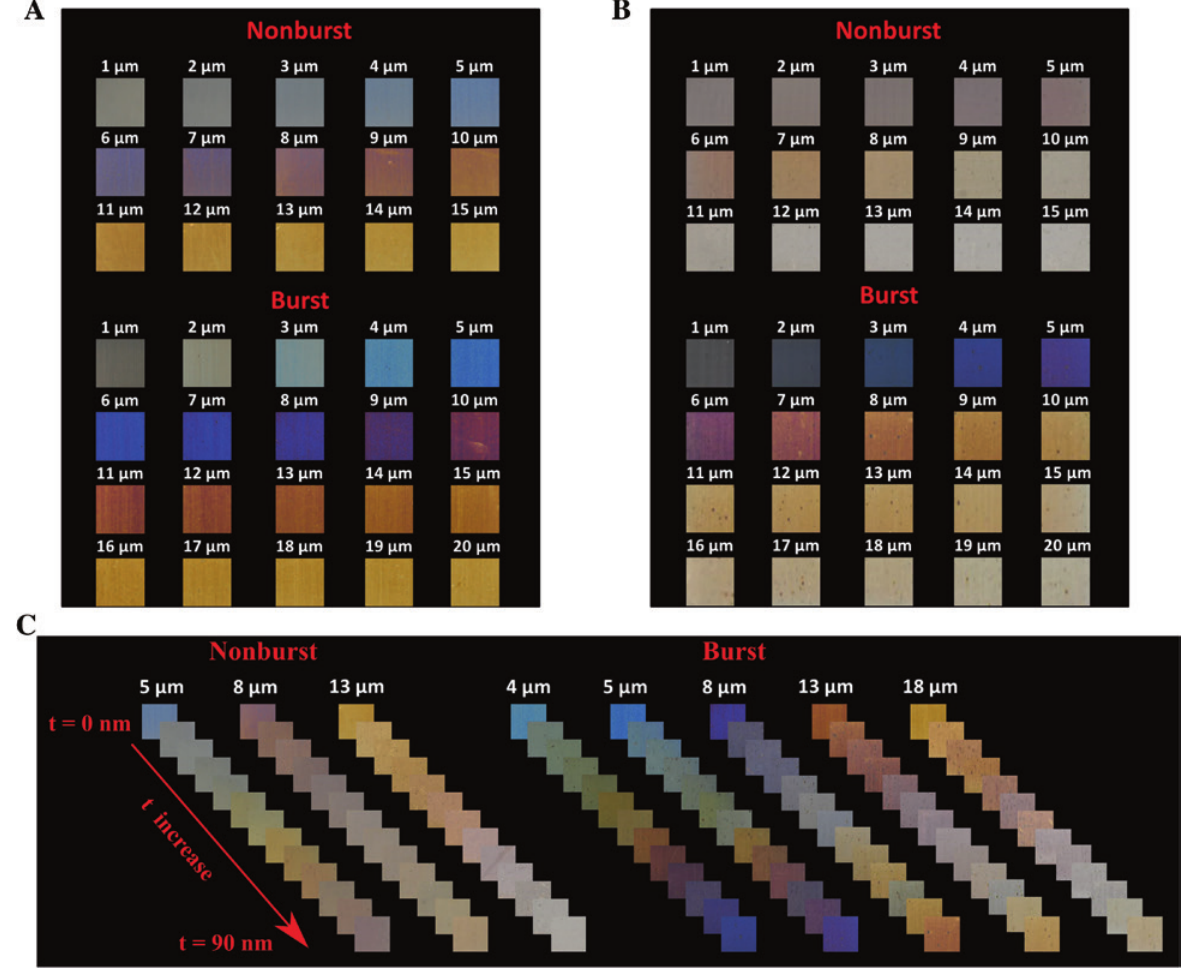
Figure 2: Colour evolution with alumina thickness. (A, B) Colour palettes obtained using the (top) nonburst and (bottom) burst laser colouring methods (A) before and (B) after the deposition of 90 nm of alumina. The different colours were obtained by changing the line spacing, L area. The colours were written using a laser fluence of 5.73 J/cm 2 with a marking speed of 100 mm/s and a laser fluence of 12.12 J/cm 2 with a marking speed of 150 mm/s for the nonburst and burst colours, respectively. (C) Colour evolution with increasing alumina thickness from 0 to 90 nm in steps of ~ 7